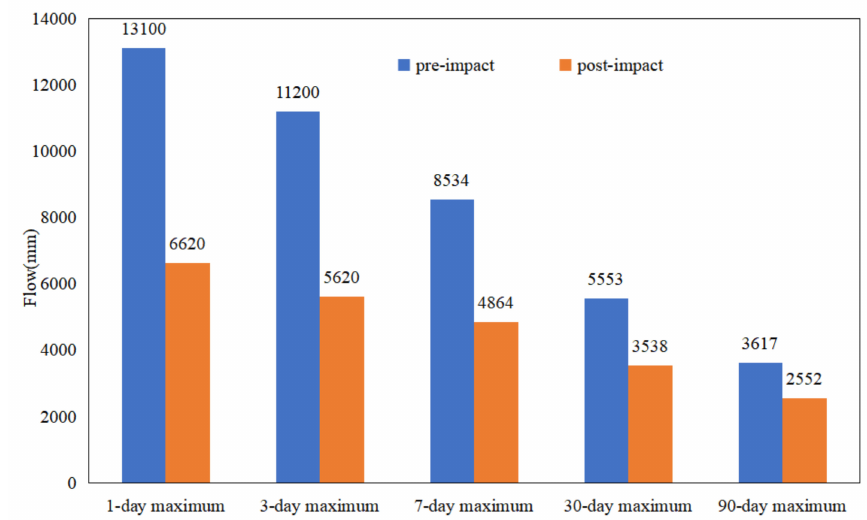
Figure 6. Comparison of maximum flow in the different